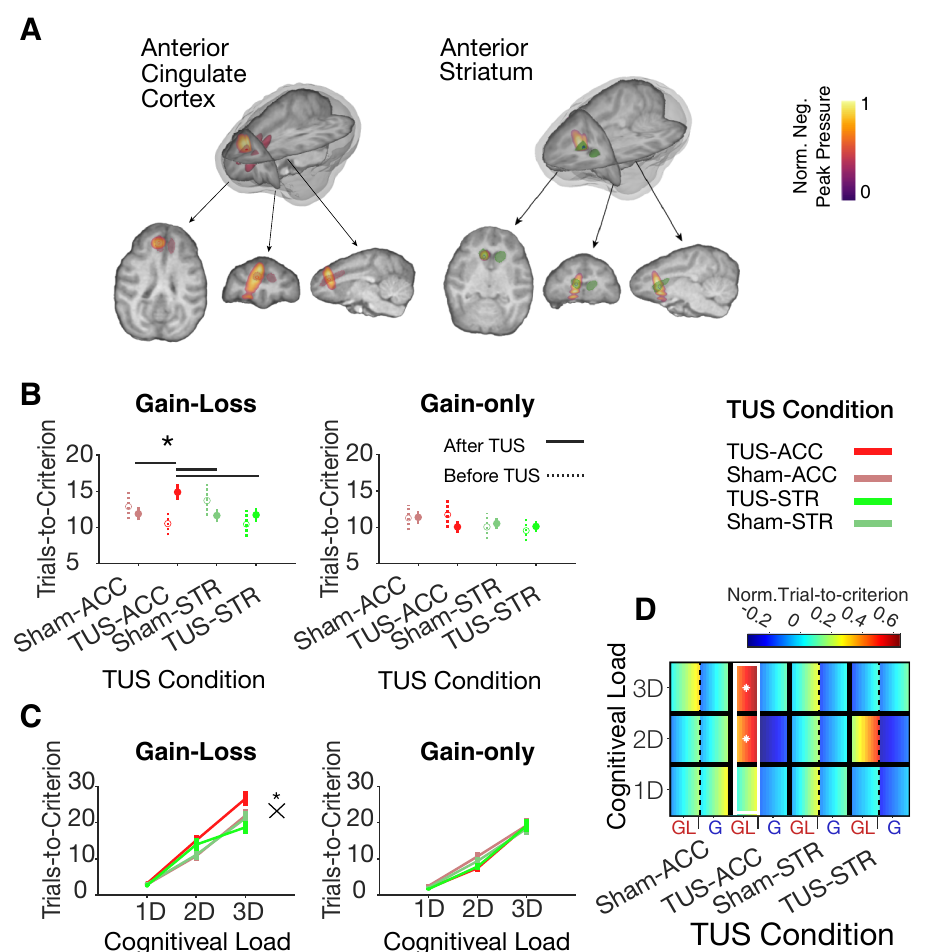
Fig 2. TUS of ACC and anterior striatum. ( A ) The maximum negative peak pressure of TUS in an example session of 1 monkey shows the focus is within ACC (left) and anterior striatum (right). ( B ) Learning is slowed down (trials-to- criterion increased) after TUS in ACC in the gain-loss context (left, LMEs, p = 0.007) but not in the gain-only contexts (right, n.s.). Data represent means and the standard error of the mean. ( C ) Learning is slowed with higher cognitive load with a significant interaction in the gain-loss context (left, LMEs, p = 0.007) but not in the gain-only context (right, n.s., for the full multiple comparison corrected statistical results, see S1 and S2 Tables ). ( D ) Marginally normalized trials-to-criterion is significantly higher with ACC-TUS in the gain-loss (GL) learning context at higher (2D and 3D) cognitive load (random permutation p < 0.05). Each cell is color coded with the mean value ± SE with a low to high value gradient from left to right. Values across learning blocks in each cell are normalized by subtracting the mean and dividing by standard deviation of all baseline learning blocks across all TUS conditions for each load and motivational context. The white rectangle indicates that learning in that TUS condition ( x-axis ) is different from other TUS conditions. White asterisks indicate that a cognitive load condition in a learning context in a TUS condition is significantly different from other TUS conditions. Black crosses ( × ) and asterisks mark significant interactions of cognitive load and TUS conditions. Black asterisks indicate significant main effects of TUS conditions and a significant difference between the TUS and the baseline (pre-TUS) conditions (for the TUS condition underneath the asterisks). Horizontal black lines indicate significant pairwise differences between TUS conditions. Data associated with this